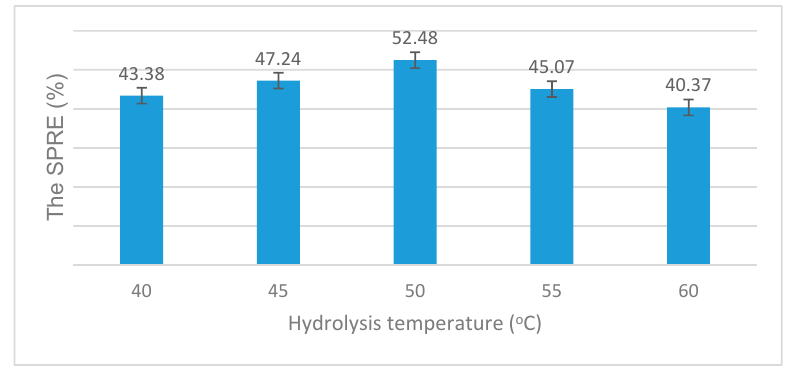
Figure 5. The e ff ect of hydrolysis temperature on the